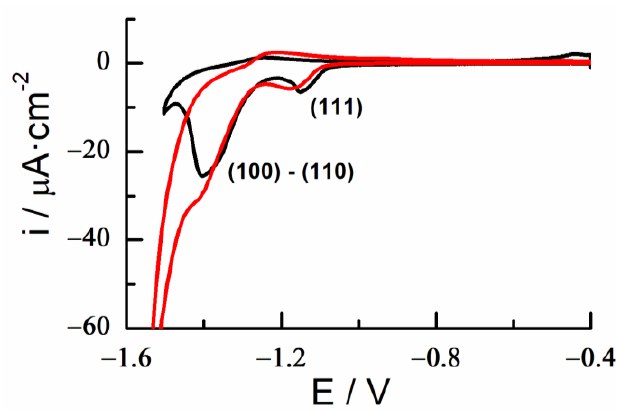
Figure 8. Reductive desorption. Cyclic voltammetry of decanethiol SAM in KOH 0.1 M of a gold 18K plate (red) and pure gold (black). Scan rate 0.02 V/s.